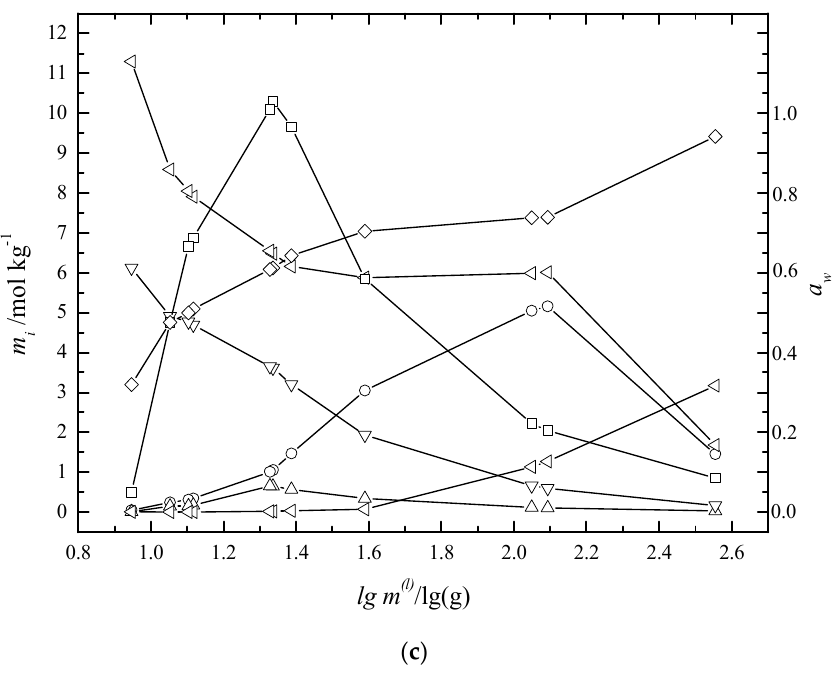
Figure 3. Open crystallization curves in the Na + , K + , Ca 2+ , Mg 2+ //Cl − , SO 42 − -H 2 O system. Dependences between the masses of solid phases ( a , b ) and composition of solution ( c ), and the solution mass m i , molality of solution; m ( s ) , mass of the solid phase; open points, calculation; solid points, experimental data. Initial composition of solution (mol · kg − 1 ): m(Na + ) = 0.485, m(K + ) = 0.010, m(Ca 2+ ) = 0.011, m(Mg 2+ ) = 0.056, m(Cl − ) = 0.565 ; initial solution mass M ( l ) 0 = 1000 g. ( a ) CaSO 4 ·2H 2 O, ○ ; Na 2 SO 4 ·CaSO 4 ,